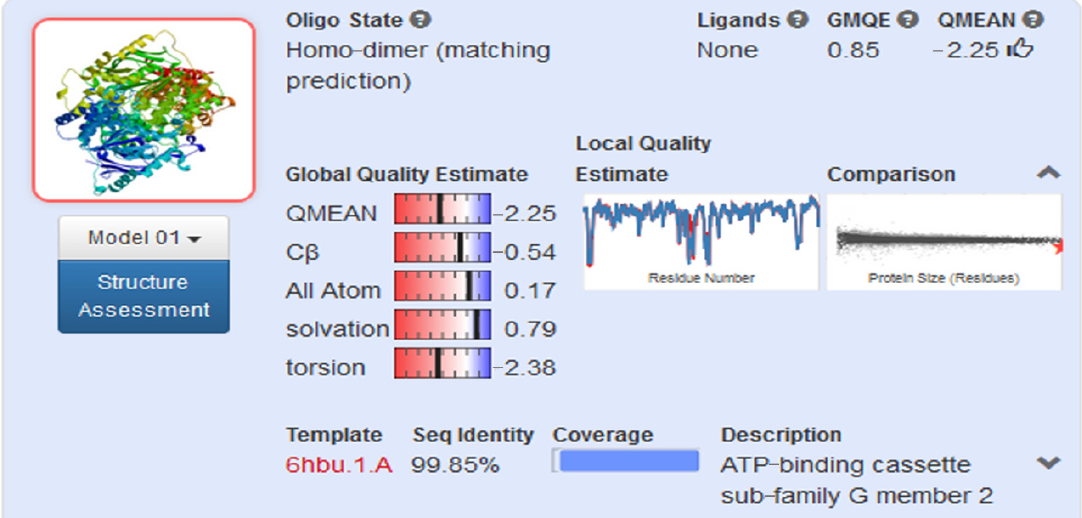
Figure 6. Parameters for evaluating homology model from SWISS-MODEL site.